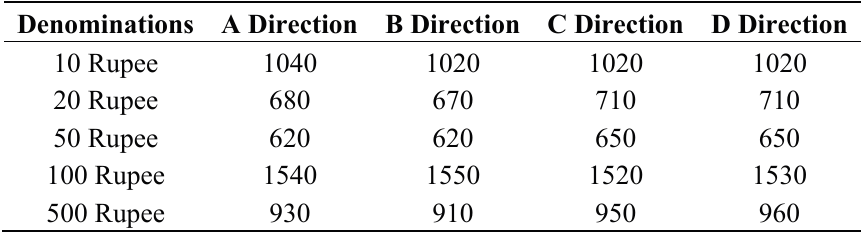
Table 2. Number of images in Indian banknote